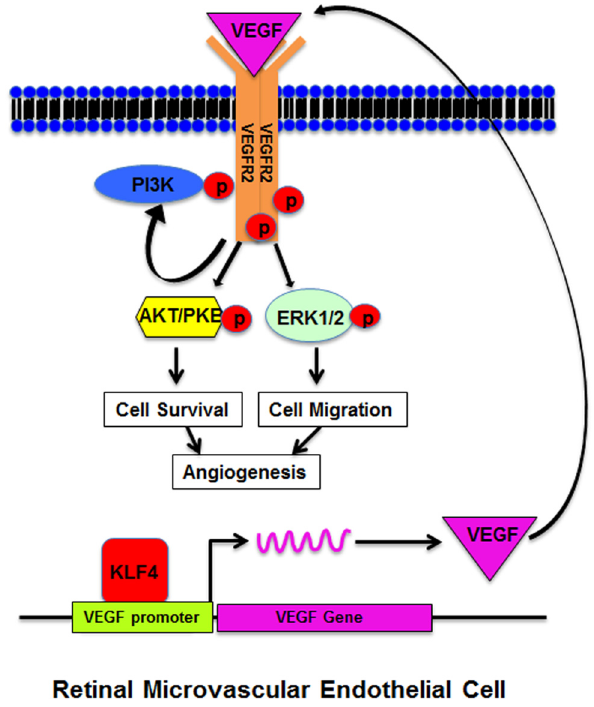
Fig 6. Schematic diagram of KLF4 mediated VEGF signaling pathway. KLF4 binds to the VEGF promoter and induces VEGF expression, subsequently phosphorylates VEGFR2 and activates downstream ERK1/2 and AKT to promote cell proliferation, migration and